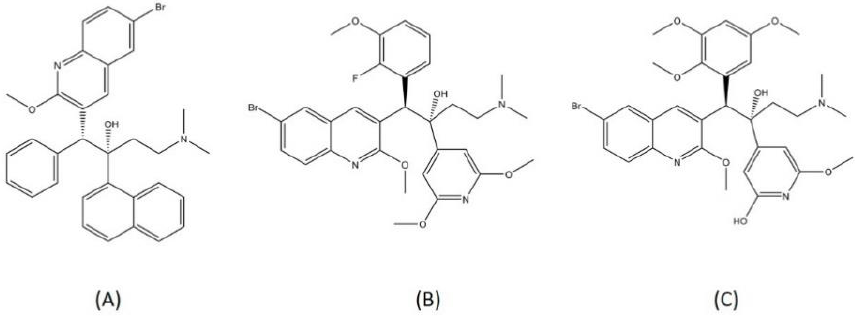
Figure 7. Structure of ( A ) bedaquiline, ( B ) TBAJ-587, and ( C )